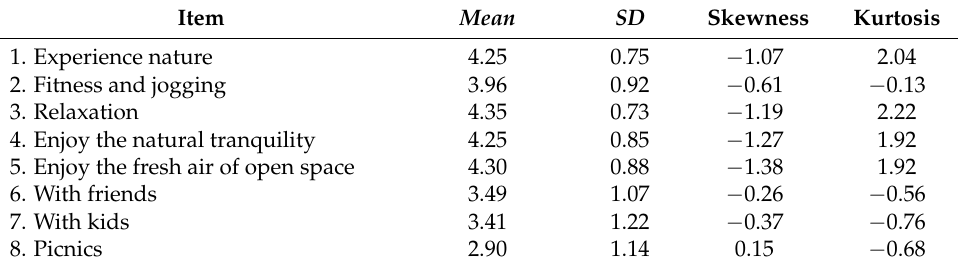
Table A5. Descriptive analysis of leisure motivations ( n = 605, 2019